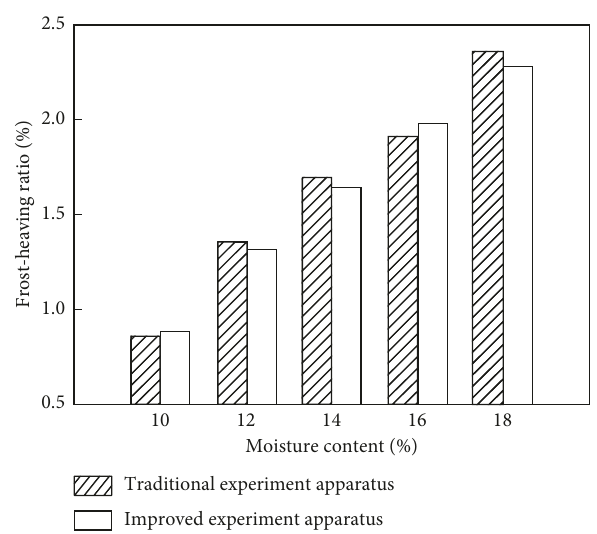
Figure 6: The contrast test between improved experiment appa- ratus and traditional experiment